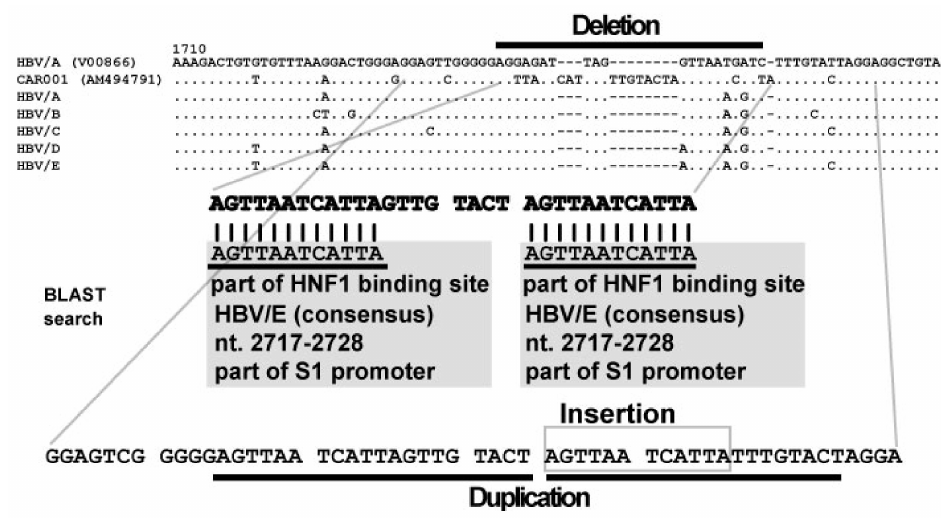
Figure 1. The pattern of complex structural variations (SVs) observed in CAR001 (AM494791) is shown. Nucleotide alignments of HBV genotype A (HBV/A)) (V00866) reference sequence and consensus reference sequences of HBV/A to HBV/E are shown with CAR001. Deletion of normal basic CP (BCP) sequences was observed, and part of the Pre-S1 promoter containing part of the hepatocyte nuclear factor 1 (HNF1) binding site was inserted. Internal duplication was also observed. HB X open reading frame (ORF) was involved. The complex SVs caused putative HBV X protein truncated 22 amino acids at the C-terminal. For the origin of the HBV strains, 39 were from Asia, followed by 9 from Europe, 9 from the Middle East, 7 from Africa and 6 from America, respectively. Detailed information of 70 strains with complex SVs are shown in additional files 1 and 2 of Reference [31]. Twenty-four were isolated from serum/plasma. For the reference sequences, we analyzed consensus reference sequences of HBV/A to E using CLUSTAL W. To determine these consensus sequences, 150, 40, 168, 79 and 38 complete genome sequences of HBV/A, HBV/B, HBV/C, HBV/D and HBV/E, respectively, were used, as described in Reference